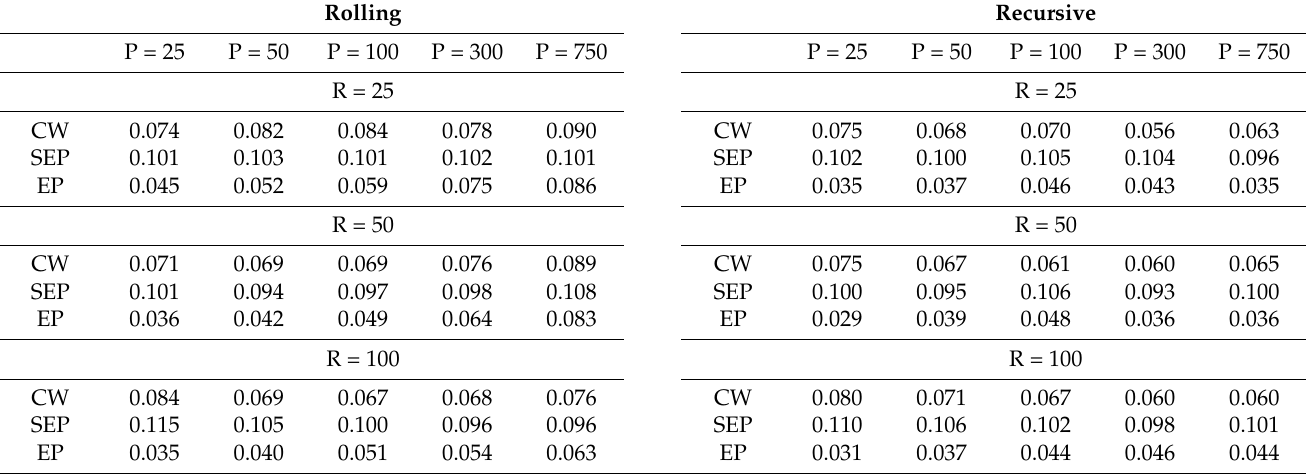
Table 1. Empirical Size DGP1; Nominal size is 10%.